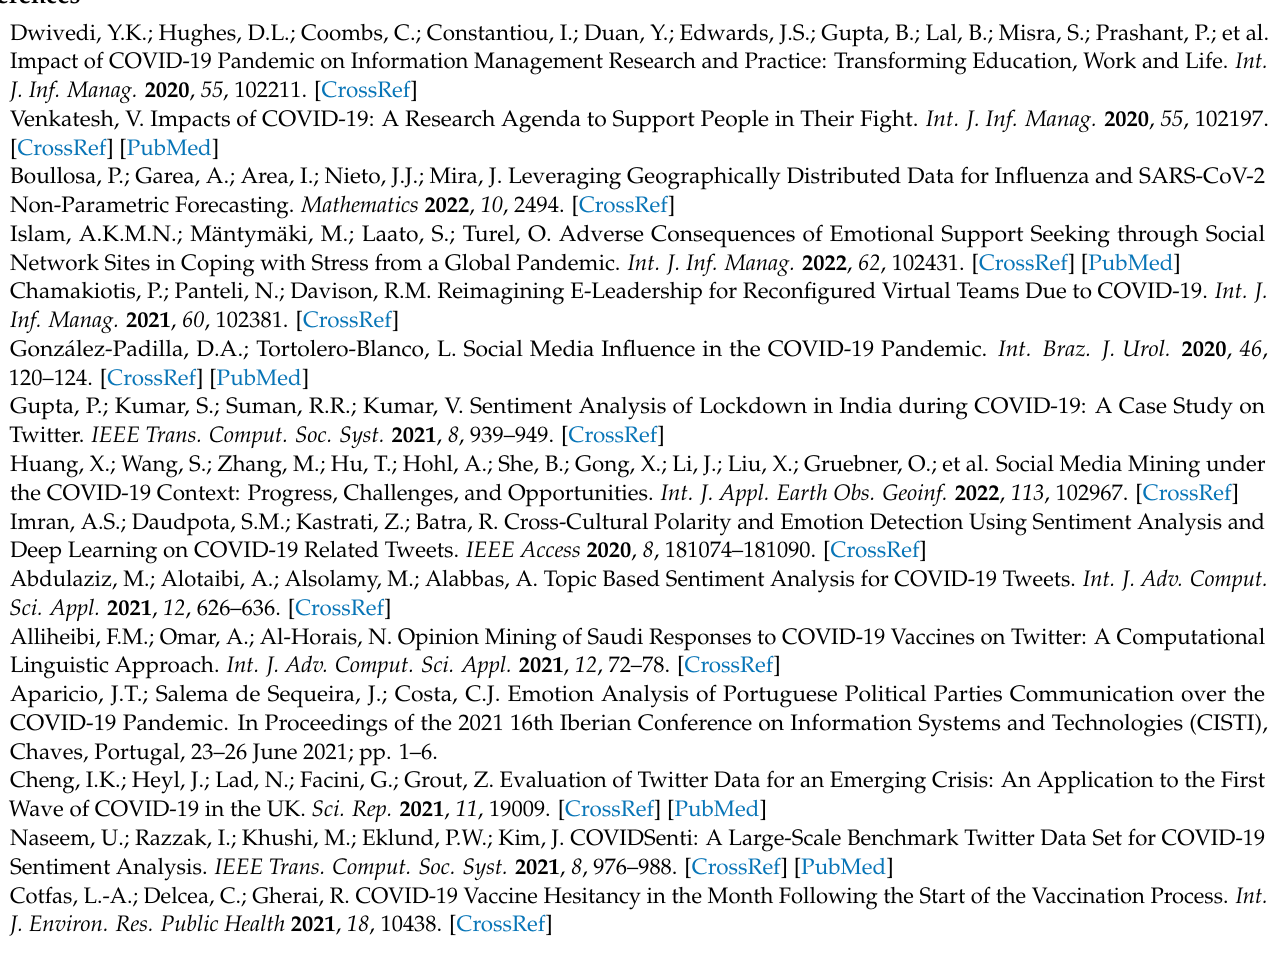
distribution on the Brazilian territory; Figure S13: Topic 15 distribution on the Brazilian territory; Figure S14: Topic 16 distribution on the Brazilian territory; Figure S15: Topic 17 distribution on the Brazilian territory; Figure S16: Topic 18 distribution on the Brazilian territory; Figure S17: Topic 19 distribution on the Brazilian territory; Figure S18: Topic 20 distribution on the Brazilian territory; Figure S19: Topic 21 distribution on the Brazilian territory; Figure S20: Topic 22 distribution on the Brazilian territory; Figure S21: Topic 23 distribution on the Brazilian